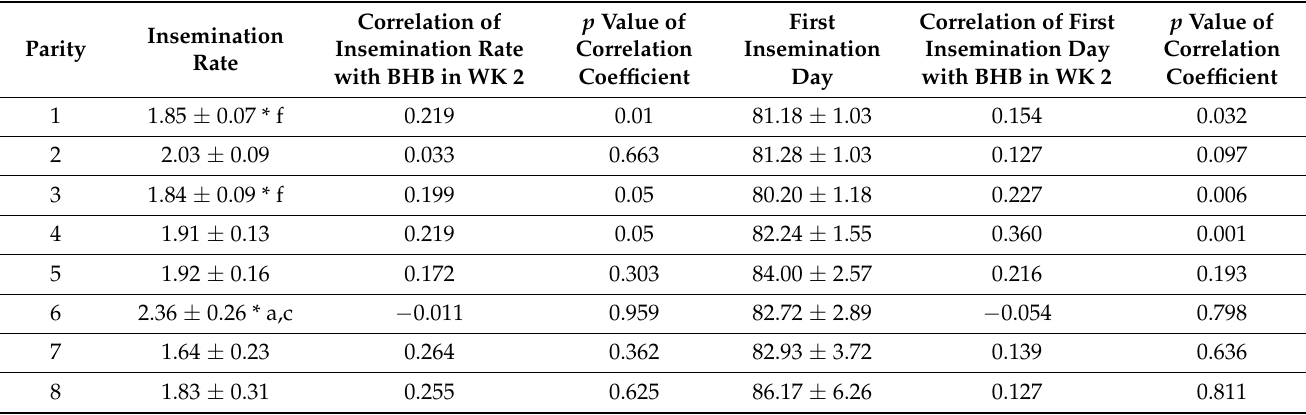
Table 4. The results of insemination rate, first insemination day in different lactations, and relationship between insemination rate and BHB concentration and insemination day and BHB